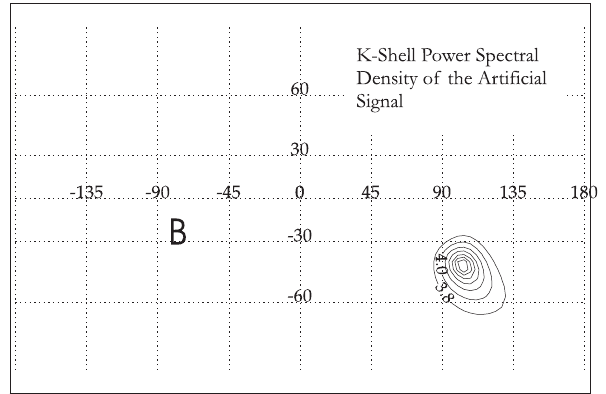
Fig. 3. Distribution of power on the k -shell k = 0 . 0036 km − 1 in a stereographic projection and logarithmic representation. B denotes the position of the mean magnetic field